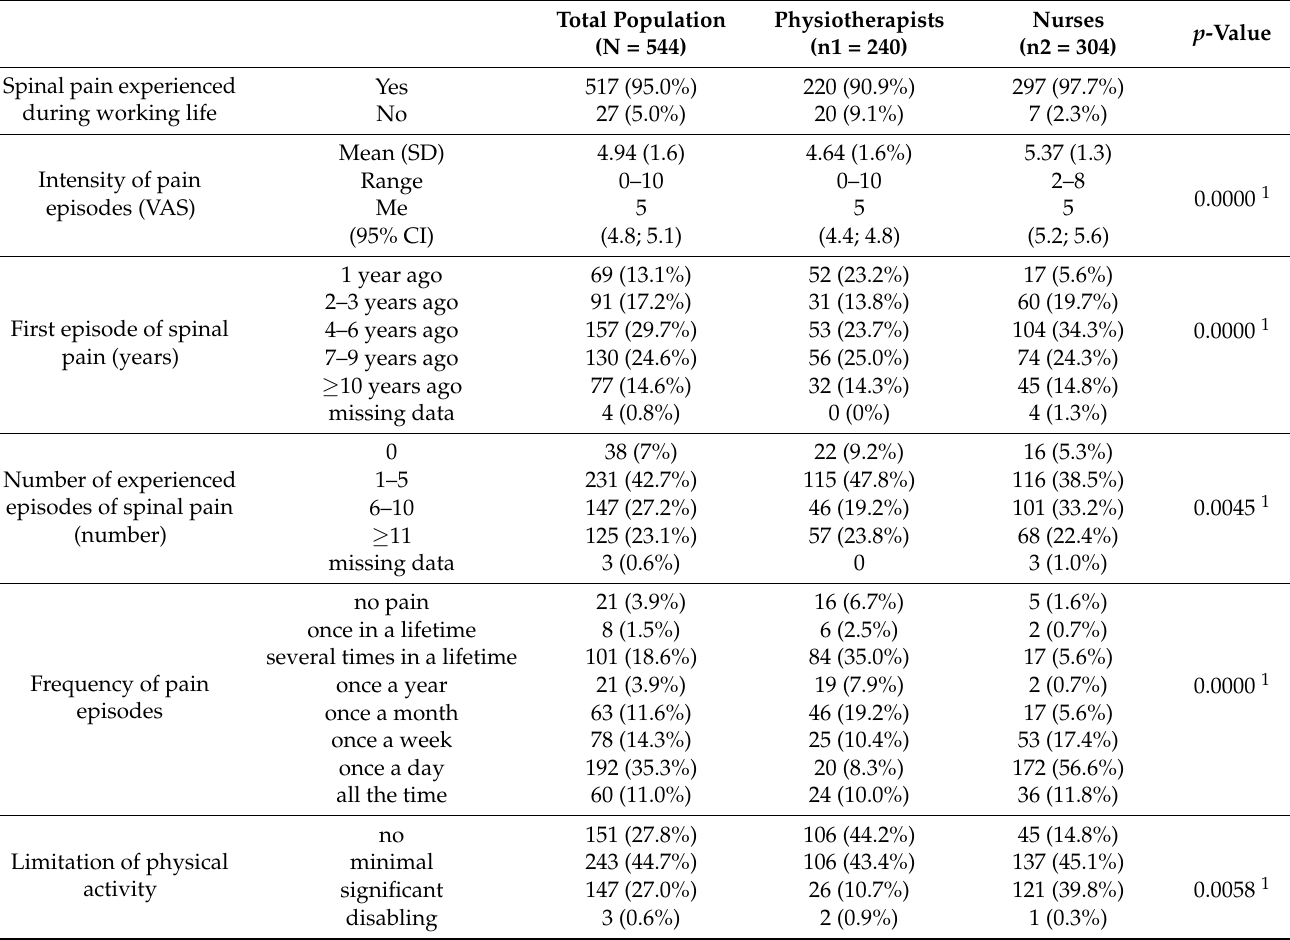
Table 3. Characteristics of pain reported by nurses and physiotherapists.